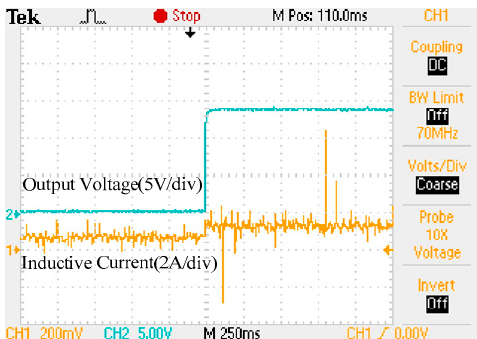
Figure 12. Experimental start ‐ up waveforms of the output voltage and inductive current under the terminal sliding mode (TSM) controller.